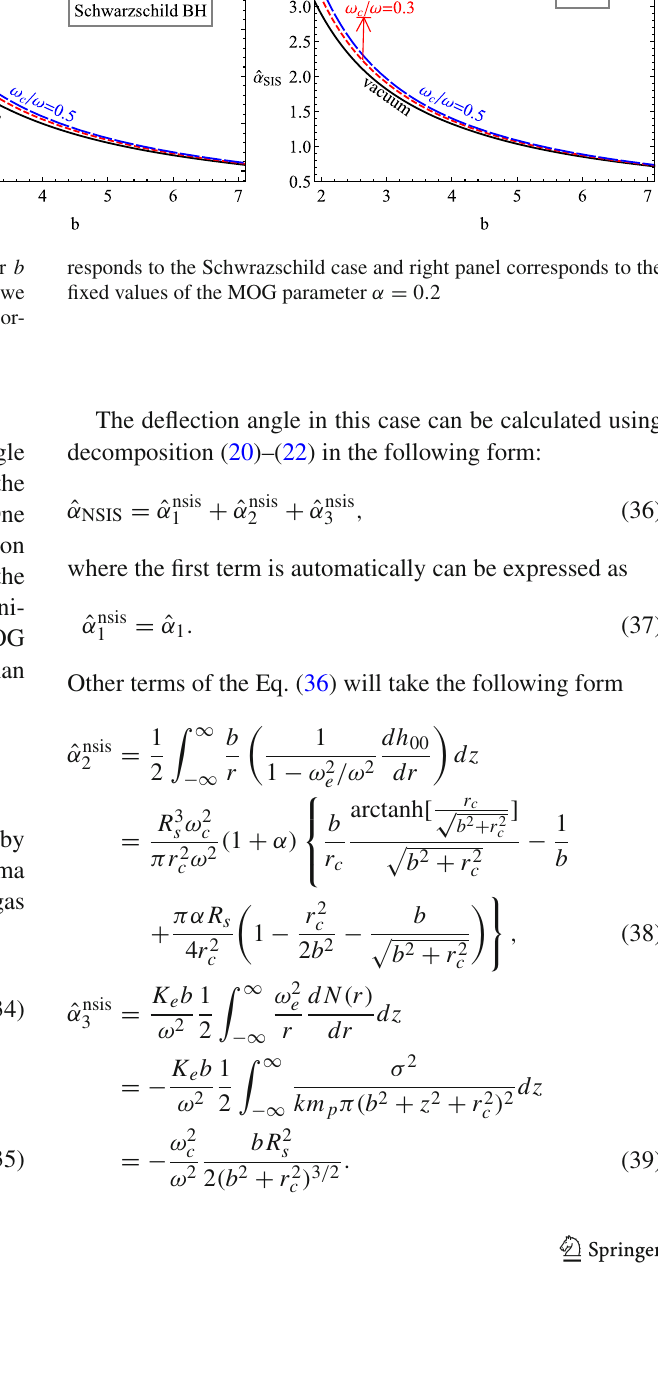
Fig. 1 Deflection angle ˆ α b as a function of the impact parameter b for different values of MOG and plasma parameters. The Left panel corre- sponds to the value of the plasma frequency ω e /ω = 0 . 5, in the middle